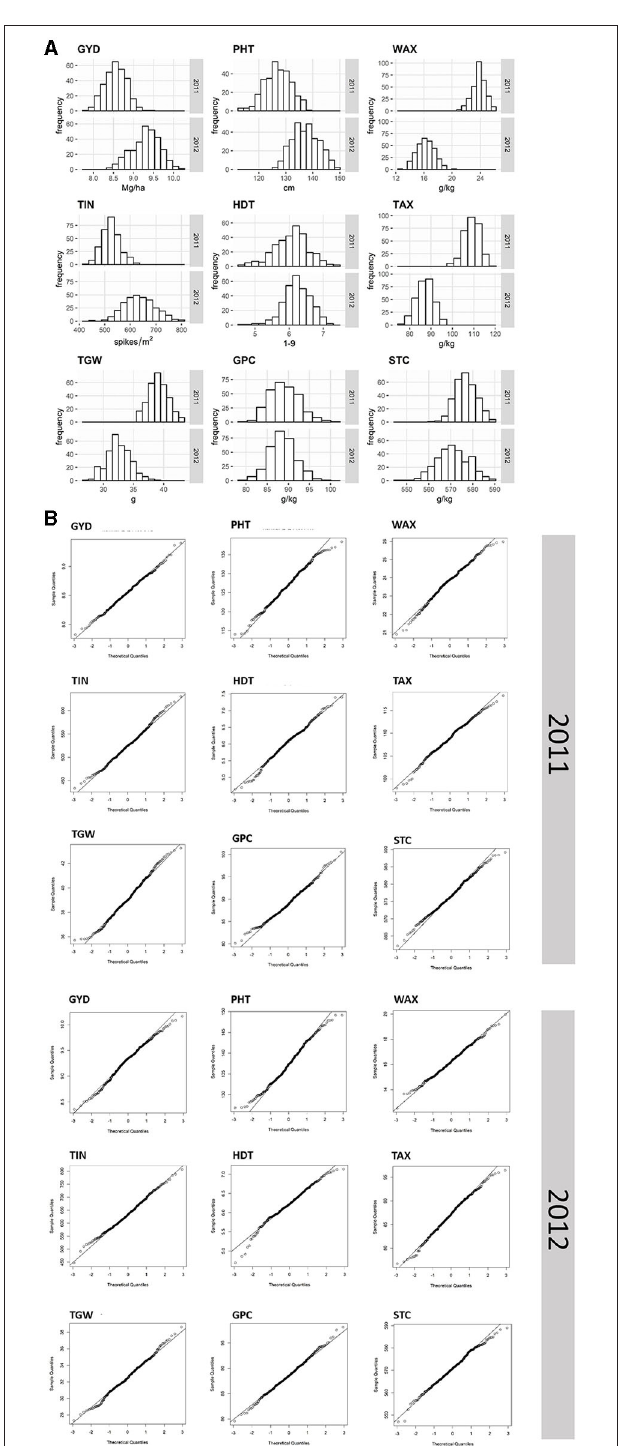
FIGURE 1 | Frequency distribution histograms (A) and Quantile-Quantile (Q-Q) plots (B) of nine agronomic and quality traits evaluated for 298 and 305 single cross rye hybrids in 2011 and 2012. The vertical axes in the histograms indicate the frequency of hybrids per trait (GYD, grain yield; TIN, tiller number; TGW, thousand-grain weight; PHT, plant height; HDT, heading date; GPC, grain protein content; WAX, water extractable arabinoxylan content; TAX, total arabinoxylan content; STC, starch content) and the horizontal axes indicate the different trait